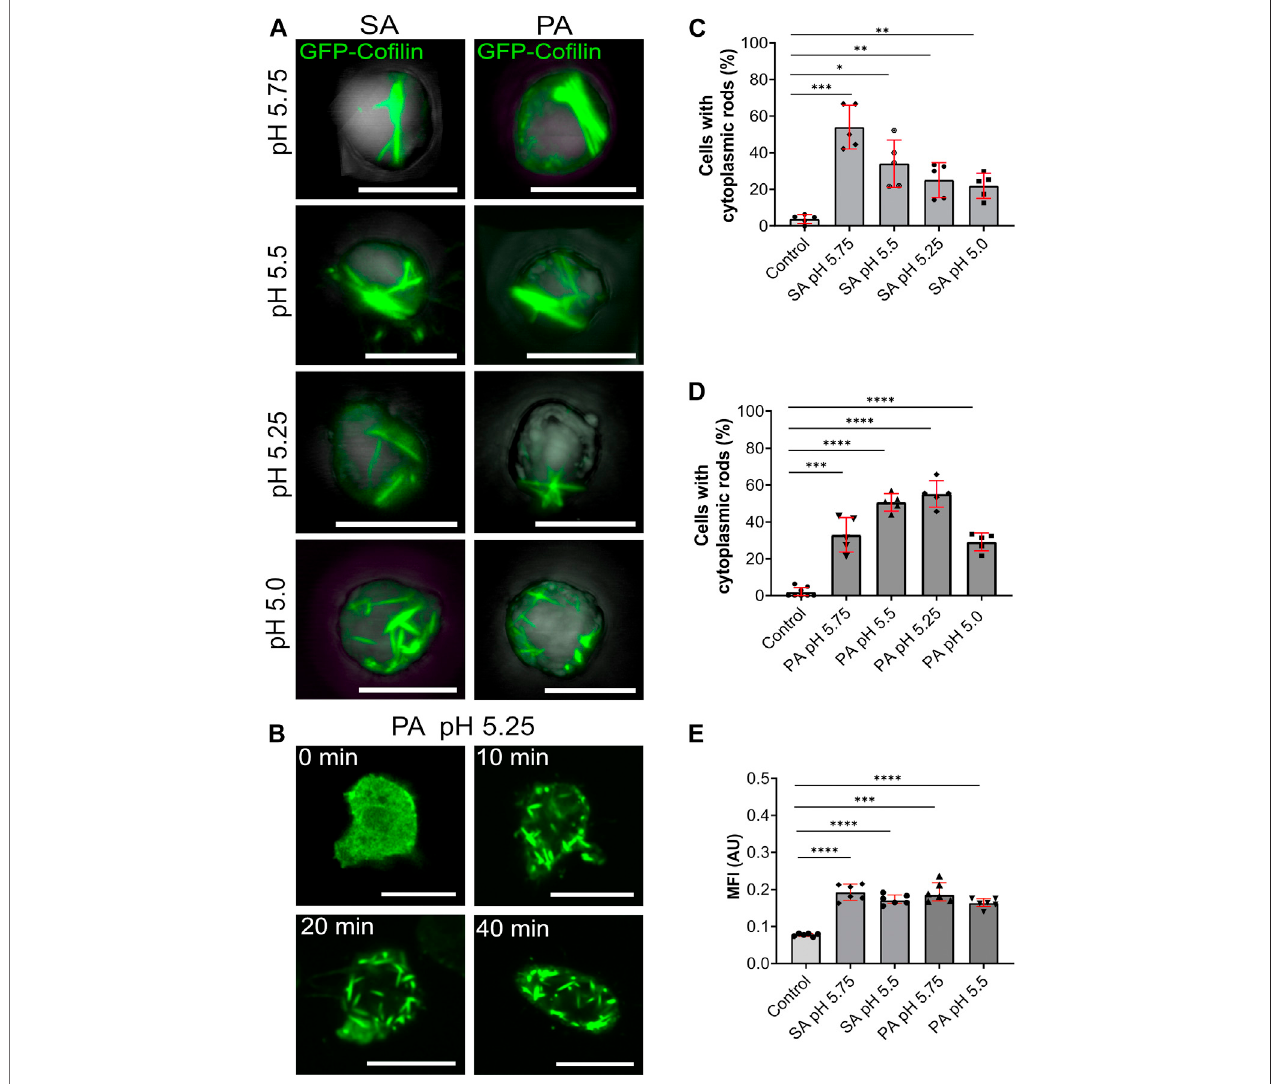
FIGURE 4 | Cytoplasmic actin-co fi lin rods are induced by lowering the intracellular pH. (A) 3D projection images of GFP-co fi lin rods (green) formed by GFP-co fi lin expressing cells cultivated for 2 h in medium adjusted to lower pH values with sorbic acid (SA) or propionic acid (PA) (pH 5.75, 5.5, 5.25 and 5.0). Scale bars are 10 µm. (B) Time lapse images of GFP-co fi lin expressing cells placed in medium adjusted to pH 5.25 with PA. After 10 min, GFP-co fi lin rods (green) start to assemble in the cytoplasm. Scale bars, 10 µm. (C,D) Percentage of cells with GFP-co fi lin rods in medium adjusted with SA (C) or PA (D) to the indicated pH values. n (cid:2) 5 experiments. (E) Ratiometric pH measurements to determine acidi fi cation of the intracellular pH. Dictyostelium cells expressing pHluorin2 cells were incubated with mediumadjustedwitheitherSAorPAtopH5.75and5.5.AnincreaseofMFIindicatestheloweringoftheintracellularpH. n (cid:2) 6experimentspertreatment.Morethan20 cellswereanalyzedforeach experimentandtreatment.Errorbarsaremedian withinterquartilerange(red). Sampleswereconsidered signi fi cantwhen p ≤ 0.05.Welch´s t-test was applied.